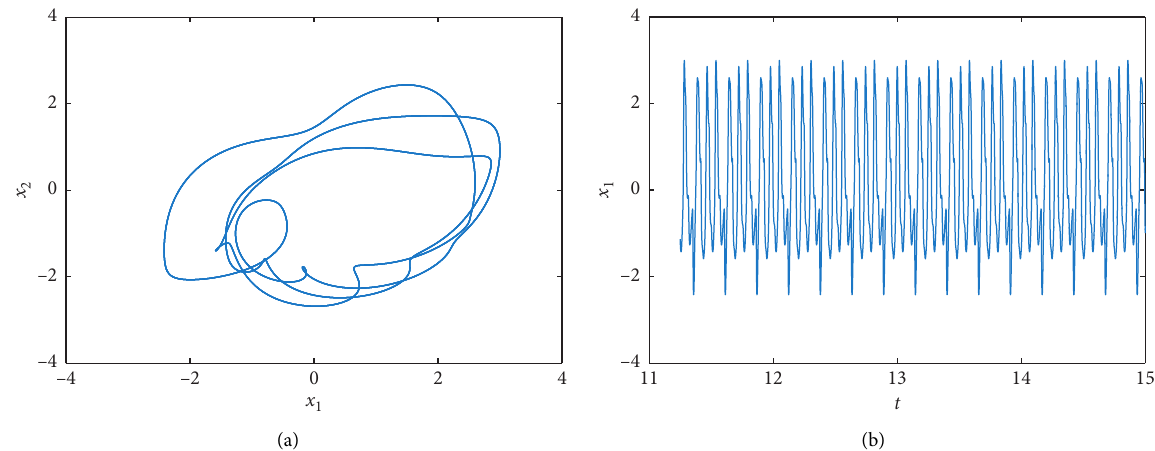
Figure 6: Phase portrait on plane ( x motion when P